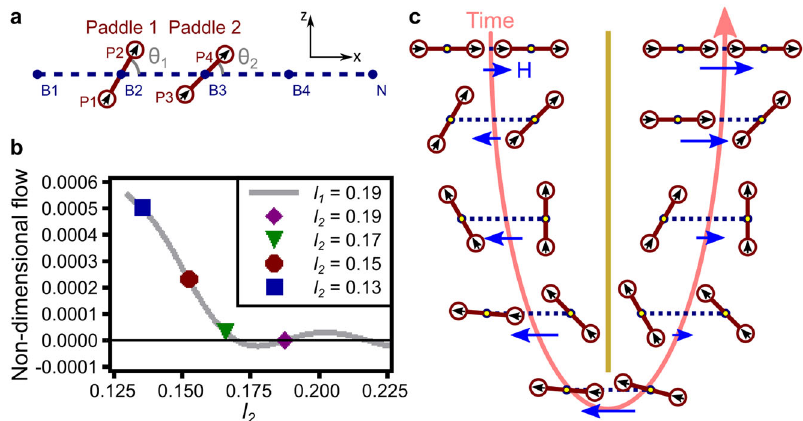
Fig. 3 Theoretical model of a membrane with cells containing two paddles with different rotational stiffness. a Geometry of a modelled cell, shown in cross-section with each paddle at a different rotation angle, θ . Solid lines represent the links within the paddles; dashed lines the links of the connecting backbone. Dots P1 – 4 are magnetic beads, dots B1 – 4 are non-magnetic beads and dot N shows the beginning of the next cell. Beads P1 – 4 are magnetized along their paddle orientation, as indicated by the arrows. b Modelled variation of x -axis fl ow with paddle 2 rotational stiffness, l 2 , at constant paddle 1 rotational stiffness l 1 = 0.19 (this l 1 reproduces the maximum rotation observed in the experimental axle of width w = 12 µ m, see Supplementary Fig. 3). Data points highlight values of l 2 when both paddles are identical ( l 2 = l 1 = 0.19) and rotational stiffnesses corresponding to the mechanics of experimental axles w = 9 µ m, 6 µ m and 3 µ m ( l 2 = 0.17, 0.15 and 0.13, respectively). c Illustration of dissimilar rotational stiffness generating non-reciprocal actuation, with left-hand paddles rotating by 60° (right-hand paddles by 45°) between time steps until rotated to near-180° and then returning to 0°. Time is represented by the arrow; the mirror symmetry in time of the driving fi eld cycle is indicated by the solid